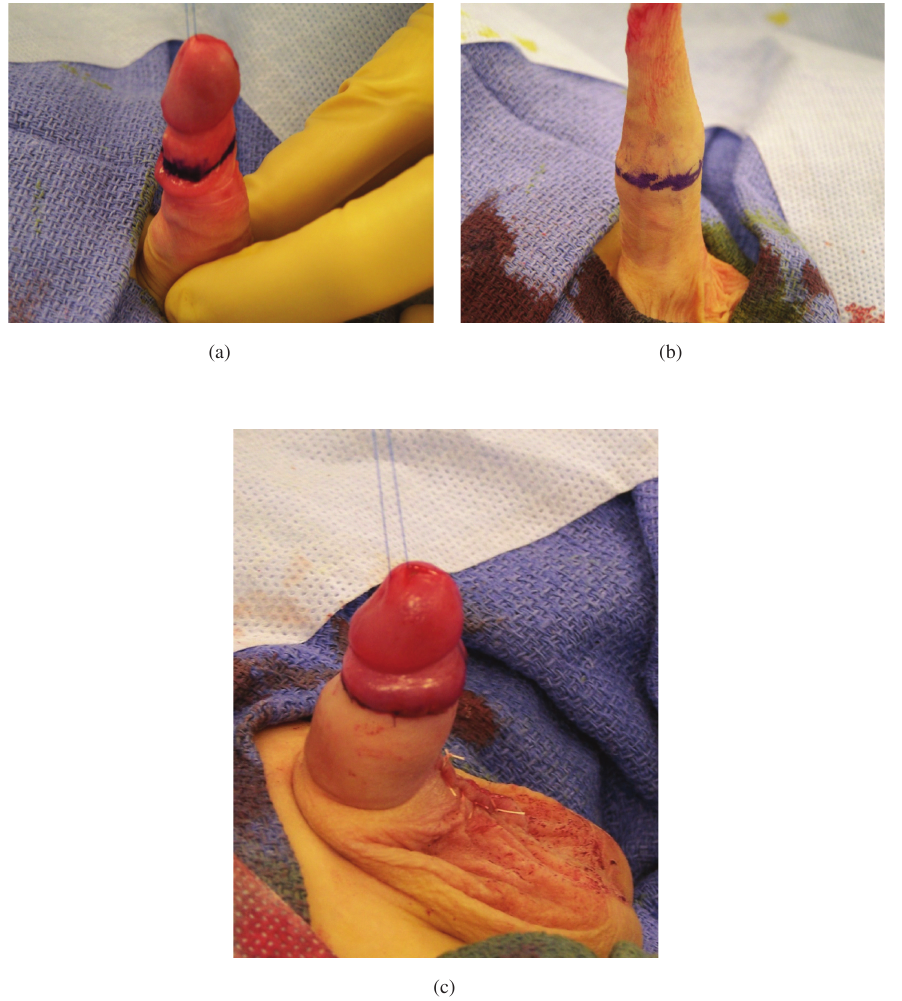
FIGURE 4: The “sleeve” technique involves incising the inner preputial skin (a) and then the overlying outer preputial skin (b). Sutures are most commonly used to approximate the skin edges